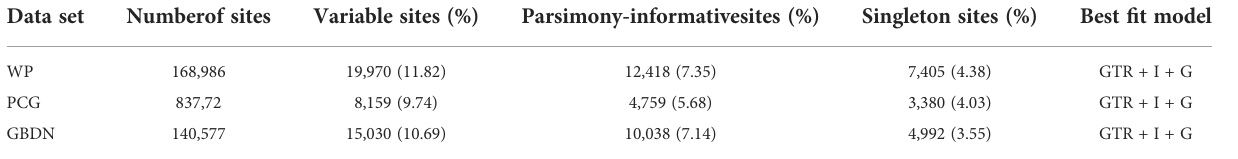
TABLE 2 Data characteristics, selected model in each data